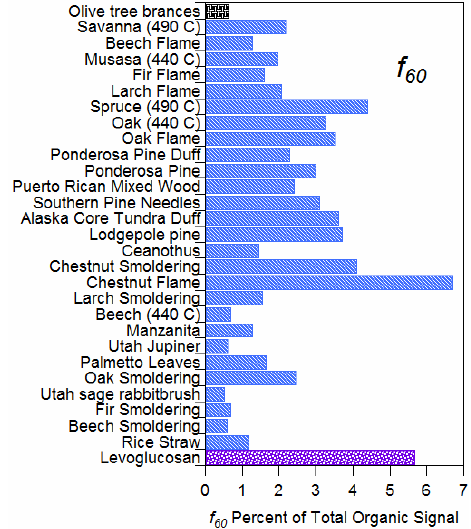
Fig. 3. Angle θ between the organic mass spectrum of the otBB- Figure 3. Angle θ between the organic mass spectrum of the otBB-OA and various BBOA mass spectra. The otBB-OA mass spectrum is quite different from the rest. (Mass OA and various BBOA mass spectra. The otBB-OA mass spectrum spectra source: http://cires.colorado.edu/jimenez-group/AMSsd/) is quite different from the rest. (Mass spectra source: http://cires. colorado.edu/jimenez-group/AMSsd/).